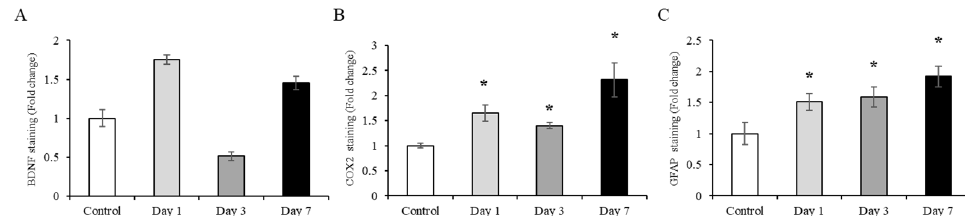
Figure 3. Quantification of acute severe-stress-induced changes in neuroinflammation marker expression in the hippocampus. Acute severe-stress-altered neuroinflammation marker expression in the hippocampus. Changes in the expression of brain-derived neurotrophic factor (BDNF), cyclooxygenase-2 (COX2), and glial fibrillary acidic protein (GFAP) were quantified using ImageJ: ( A ) BDNF; ( B ) COX2; and ( C ) GFAP expression changes in the hippocampus. Data are expressed as means ± SD; * p < 0.05, n = 6 per group.